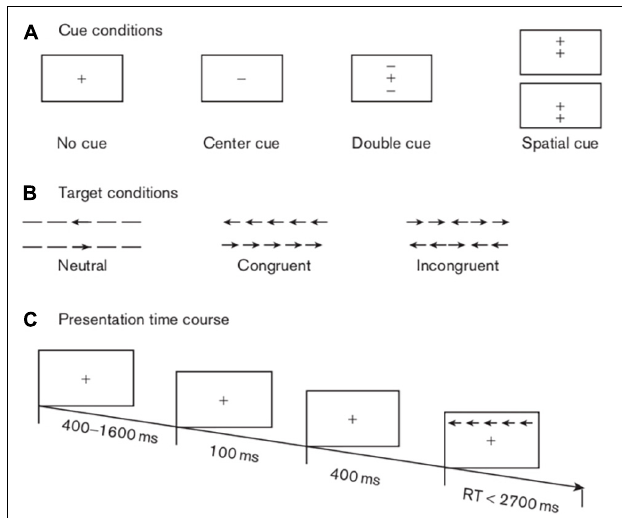
FIGURE 1 | Schematic of the attention network test. This schematic shows the experimental procedure, the four cue conditions, and the three types of target